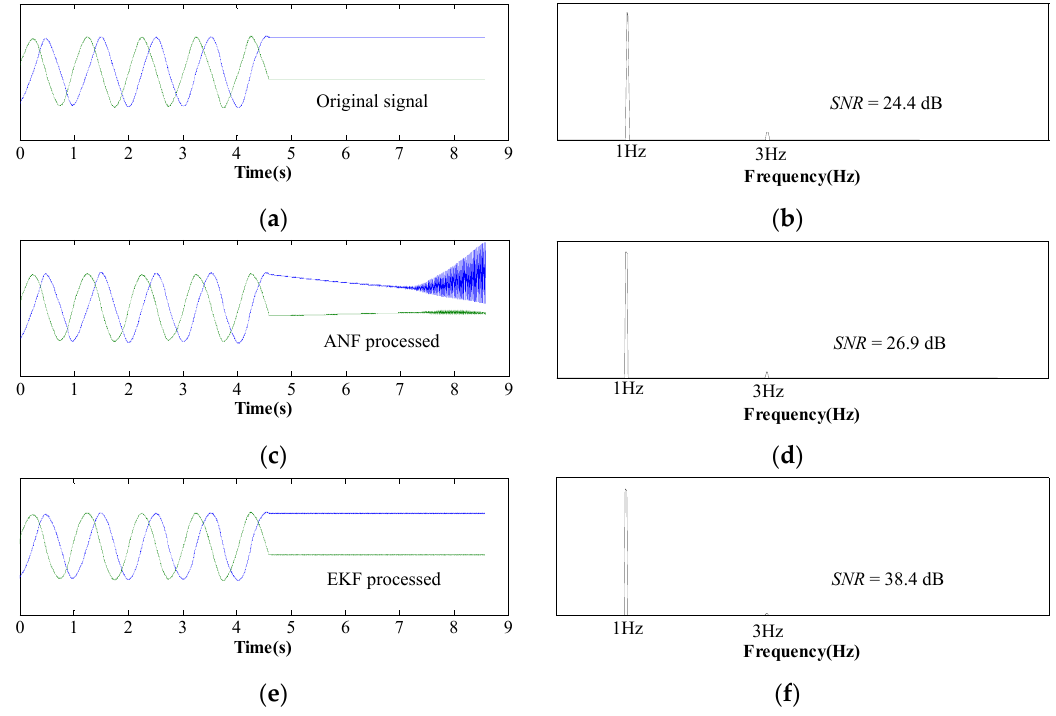
Figure 7. Waveforms and FFT results of sensor signals at 20mm/s. ( a , b ) Original sensor signals. ( c , d ) ANF processed signals. ( e , f ) EKF processed signals.